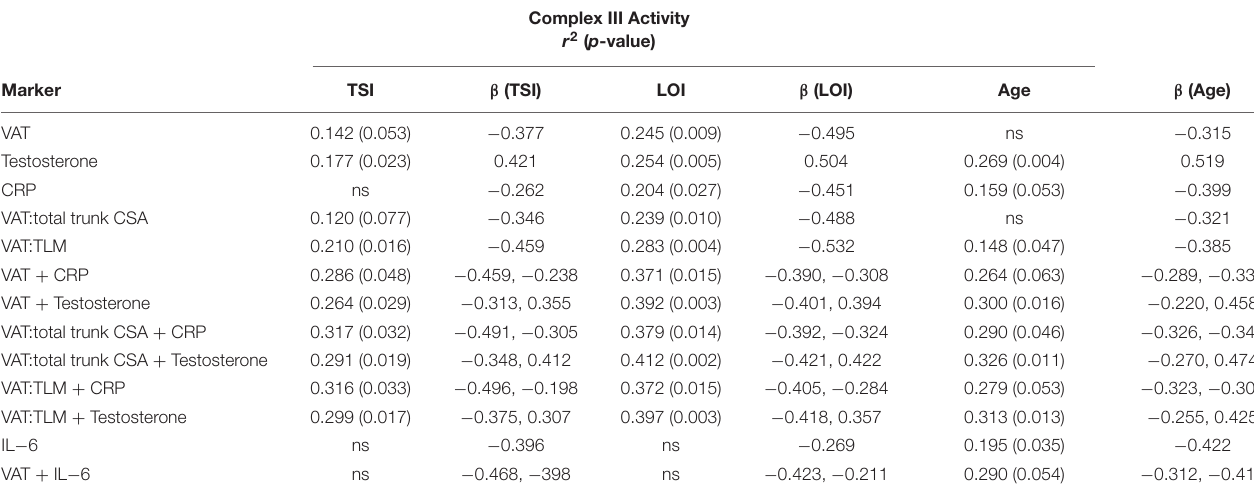
TABLE 6 | Single and multiple regressions predicting Complex III Activity after controlling for TSI, LOI, or